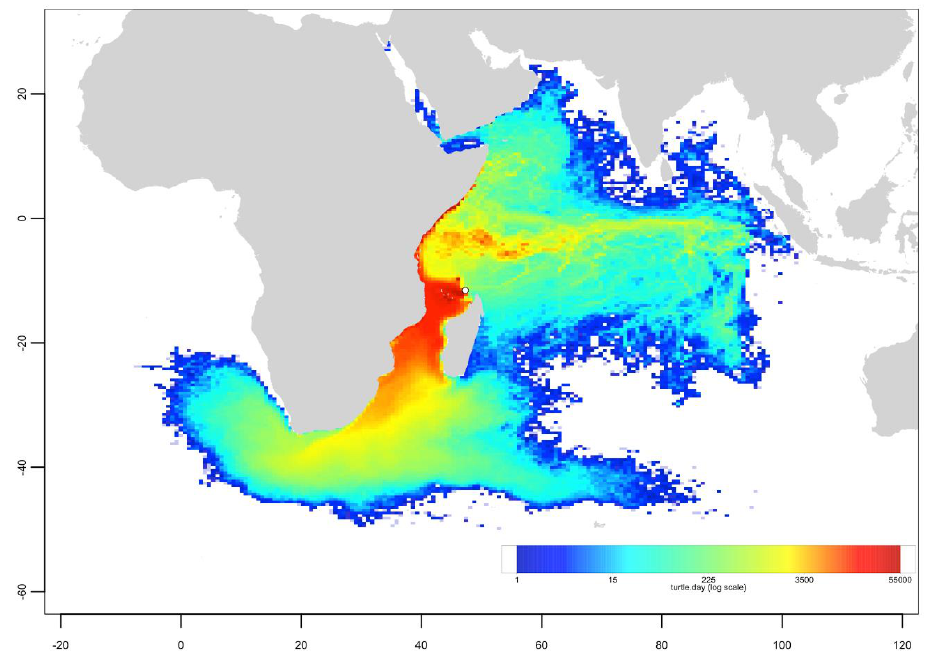
Figure A4. Glorieuses dispersal map. One-year long trajectories of 10,000 particles released from a 0.25° × 0.25° areas located about 40 km off the main nesting beaches of Glorieuses (with circle) from 2002 to 2006 (for a total of 50,000 particles). The color indicates the density of particles in number of turtles per day (log scale).